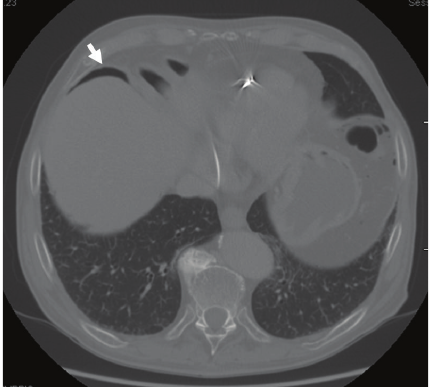
Figure 3: Abdominal CT scan showing free intraperitoneal air near the liver.